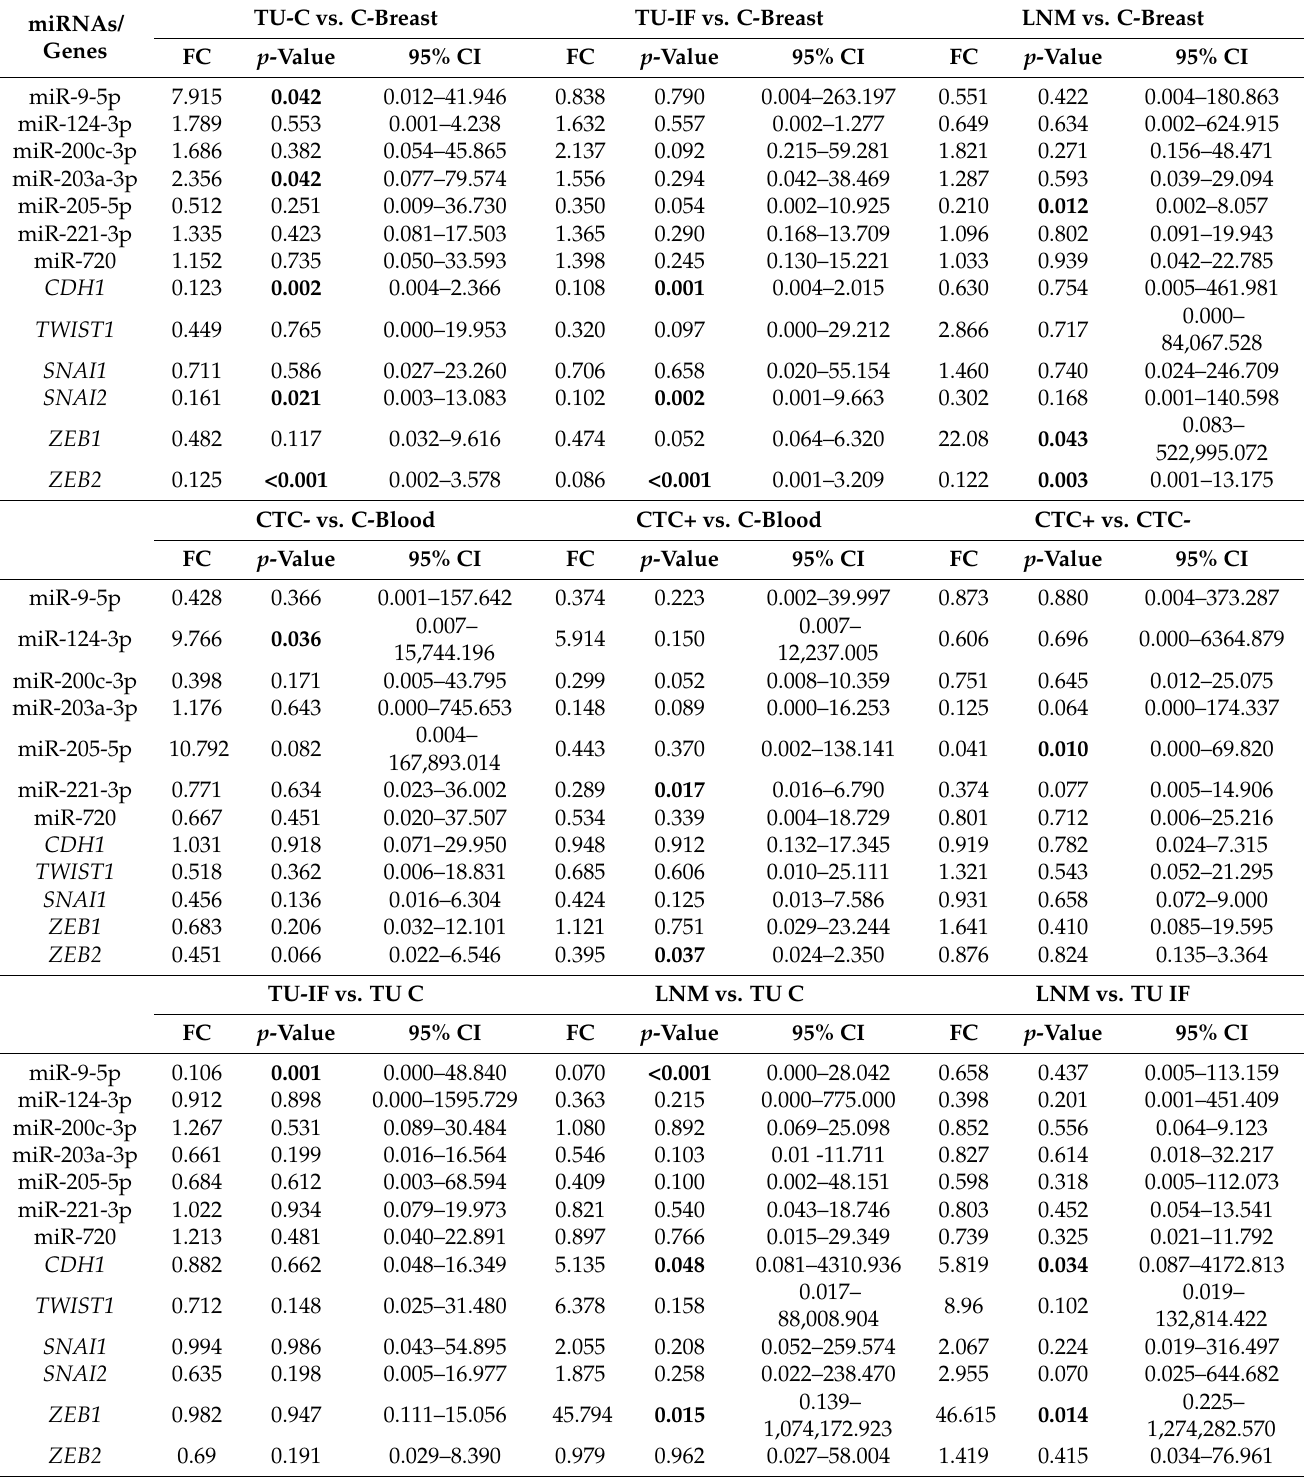
Table 1. Comparison of miRNA and mRNA of CDH1 and EMT gene expressions between controls and different types of BC patients’ specimens and between each other’s